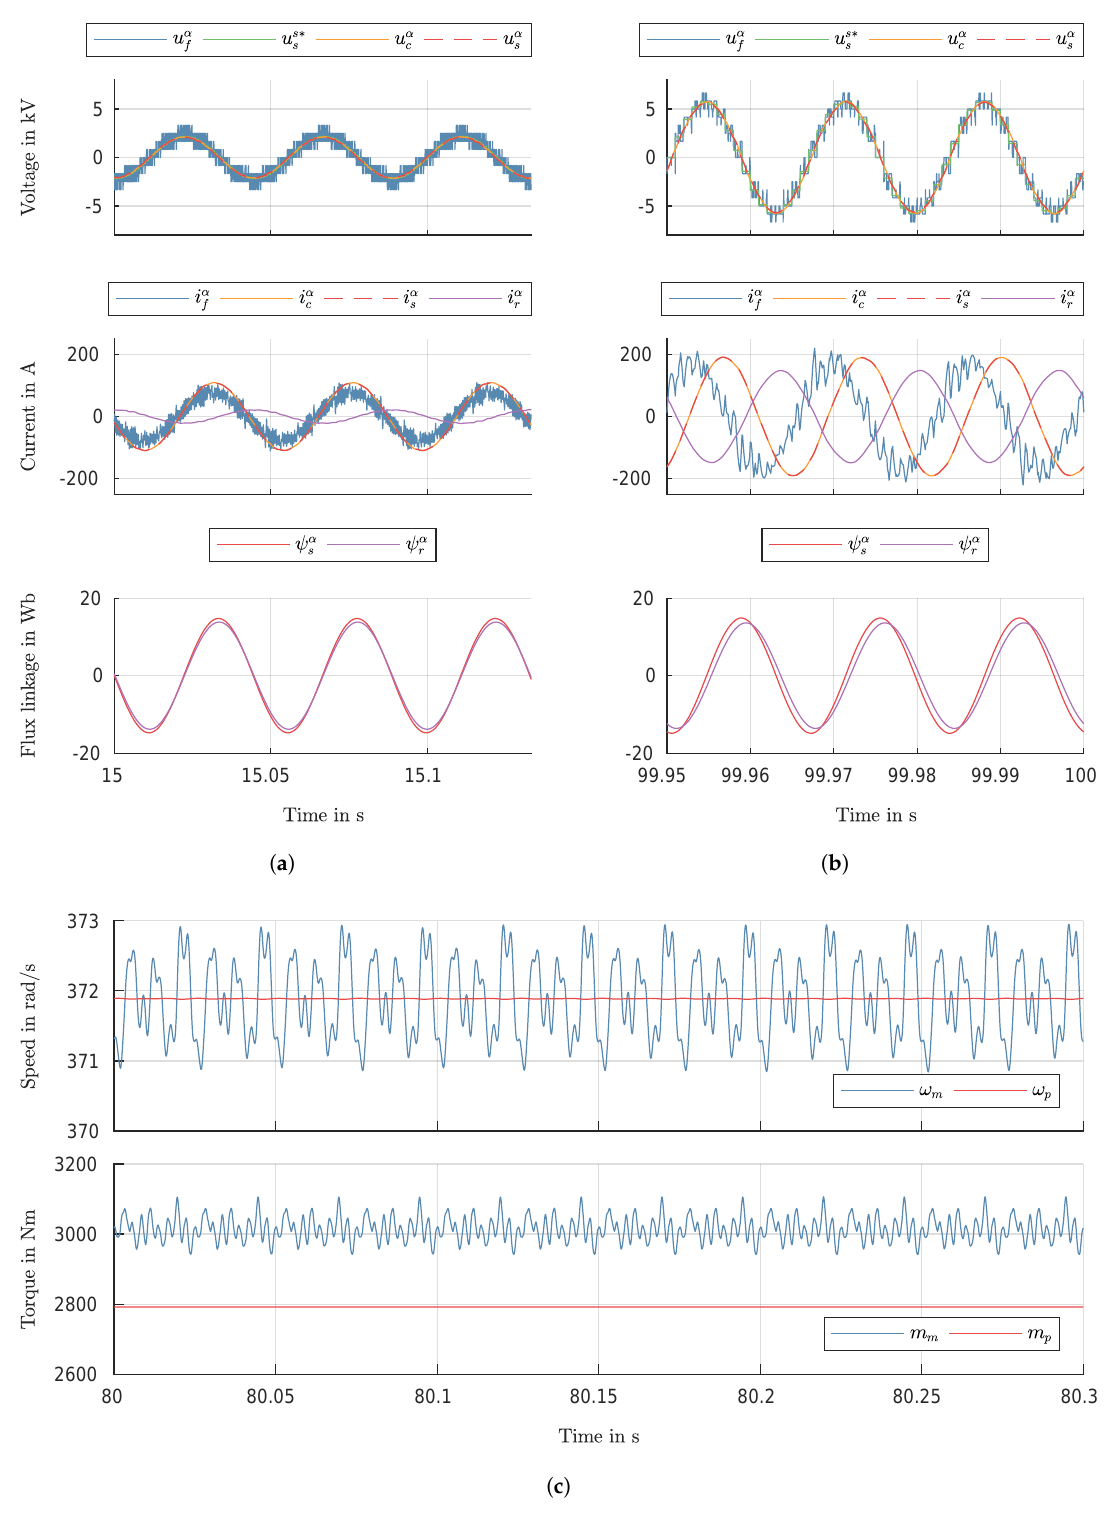
Figure 15. Simulation results (III): Detailed views of the electrical ( a , b ) and mechanical ( c )